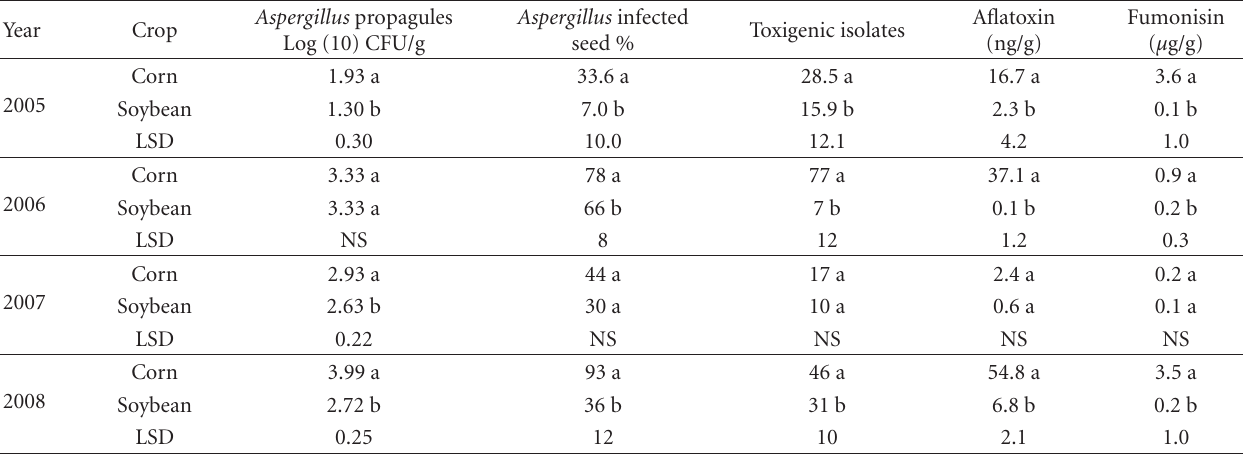
Table 4: Seed quality parameters relating to mycotoxin contamination in corn and soybean averaged among rotations 2005 to 2008. 1